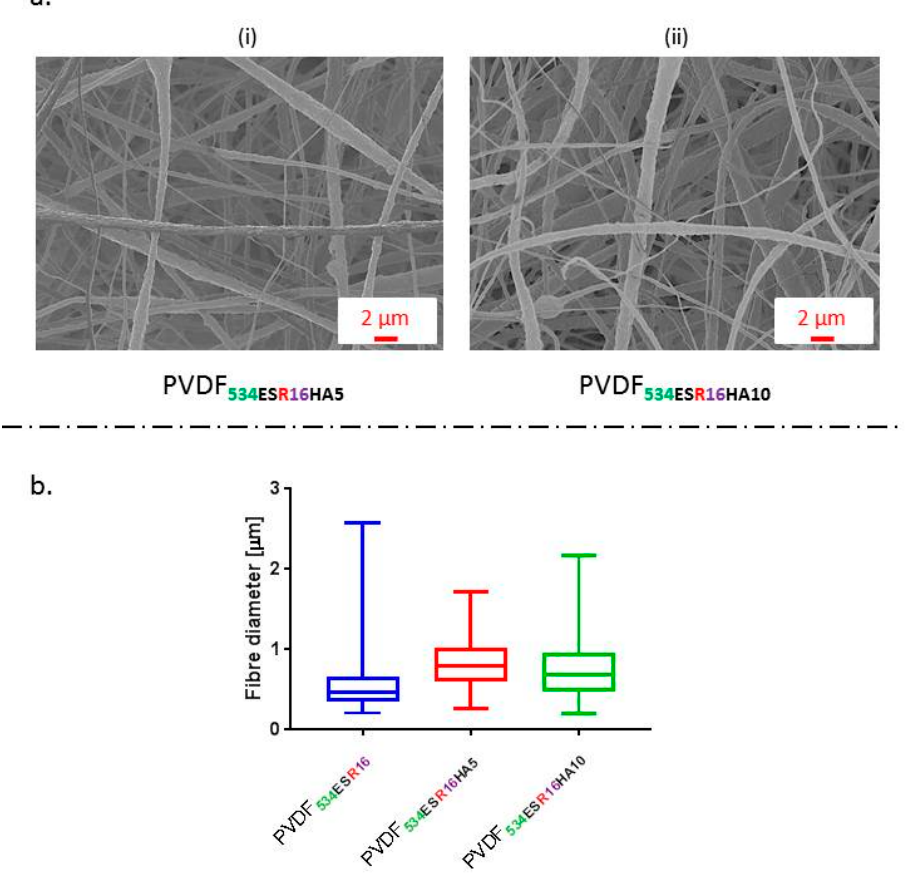
Figure 6. ( a ) SEM images of composite fibre mats obtained by inclusion 5 wt.% (i) and 10 wt.% (ii) HA in PVDF, ( b ) fibre diameter distribution of the ES composite fibres in comparison to neat PVDF fibres.